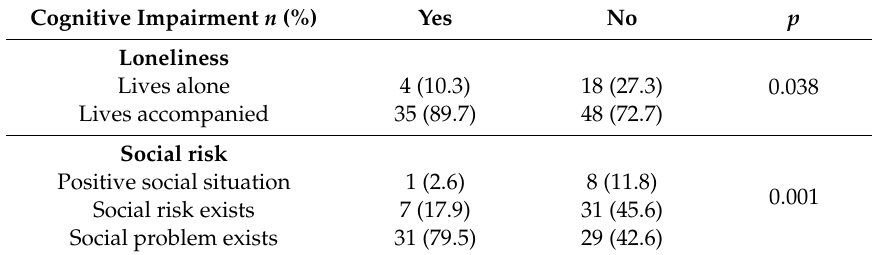
Table 2. Relationship between cognitive impairment and loneliness and social